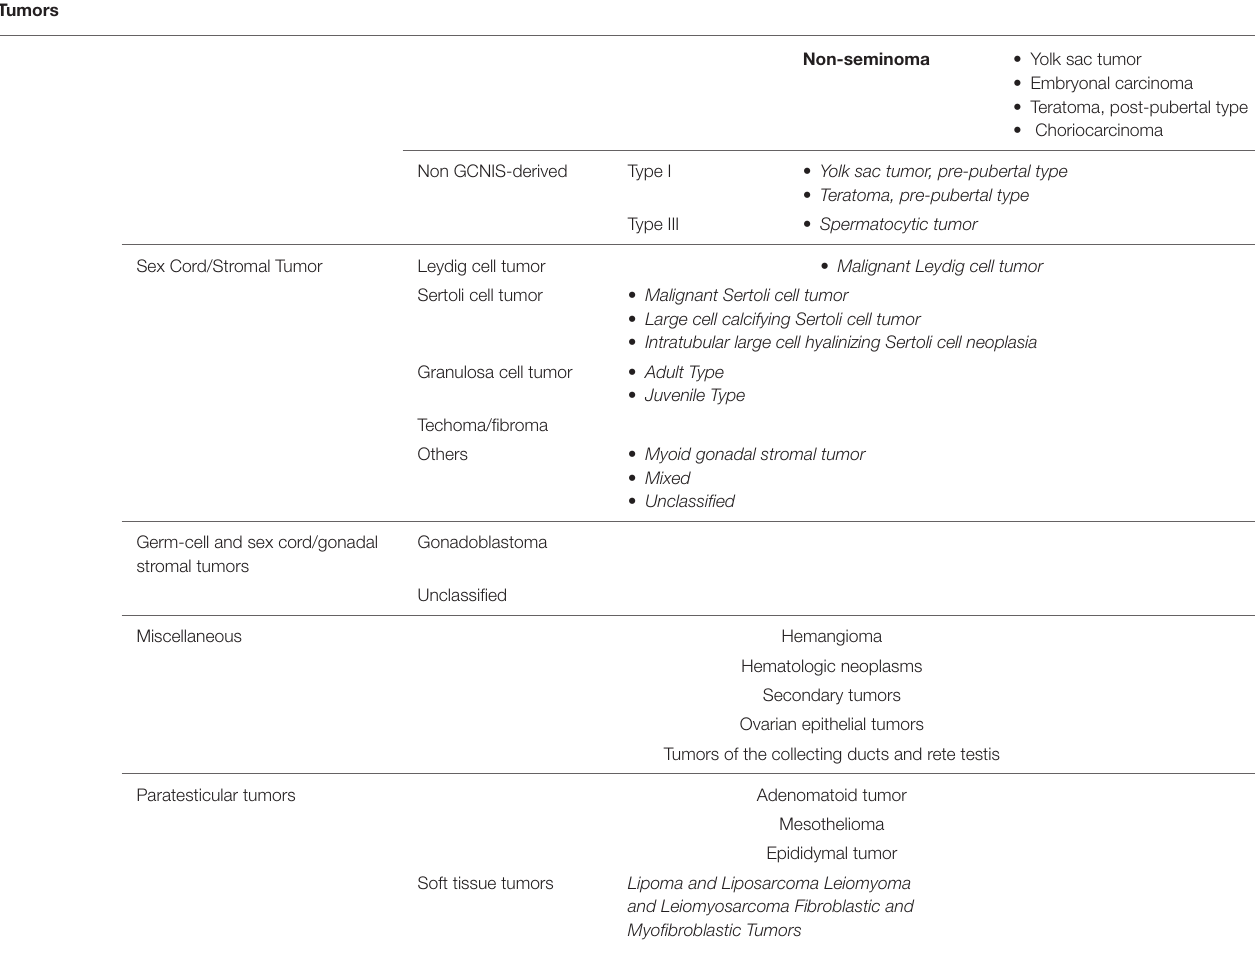
TABLE 1 | Classification of testicular tumors. Testicular